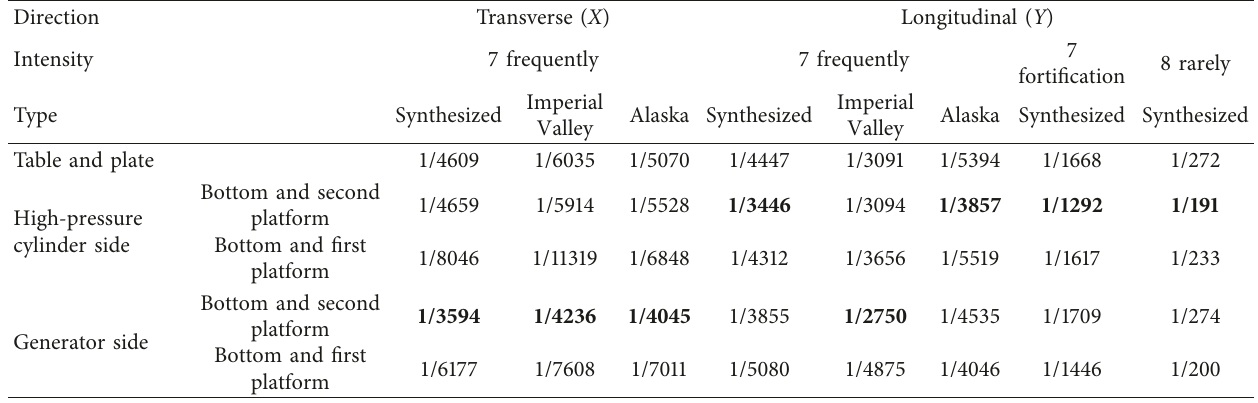
Table 5: The story drift of different locations in foundation.